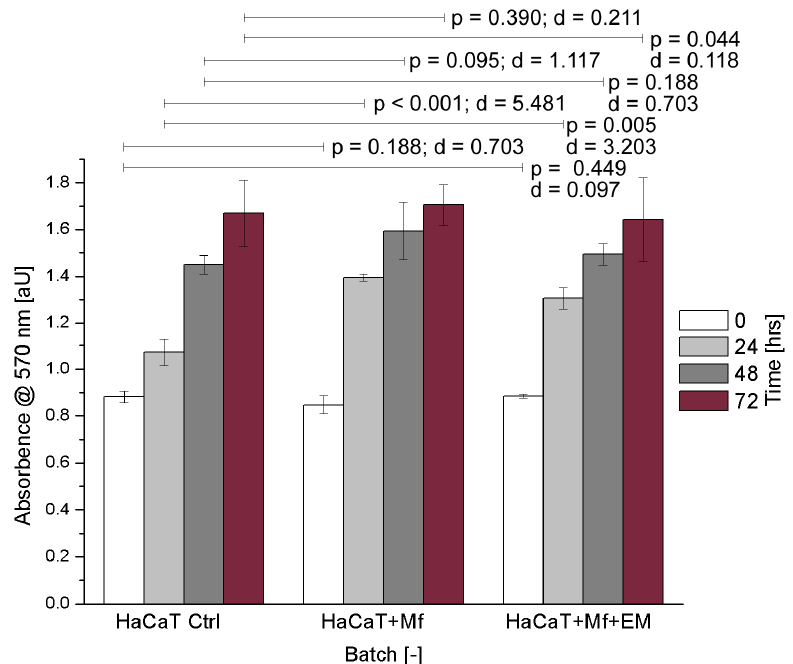
Figure 2. HaCaT cell cultures showing the control, M. furfur -infected, and M. furfur -infected cells that have been treated with the uwf-EM signal. Both the calculated effect sizes (d) and p -values ( p < 0.05) highlight the inexistence of a statistically significant difference after 72 h with p = 0.390 vs. d = 0.211 for HaCaT + M. furfur exposure and p = 0.044 vs. d = 0.118 for HaCaT + M. furfur + uwf-EM exposure combined.